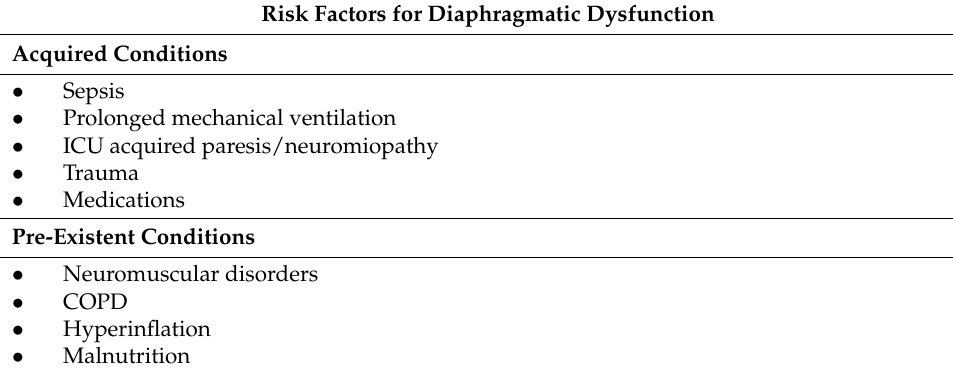
Table 2. Risk factors for diaphragmatic